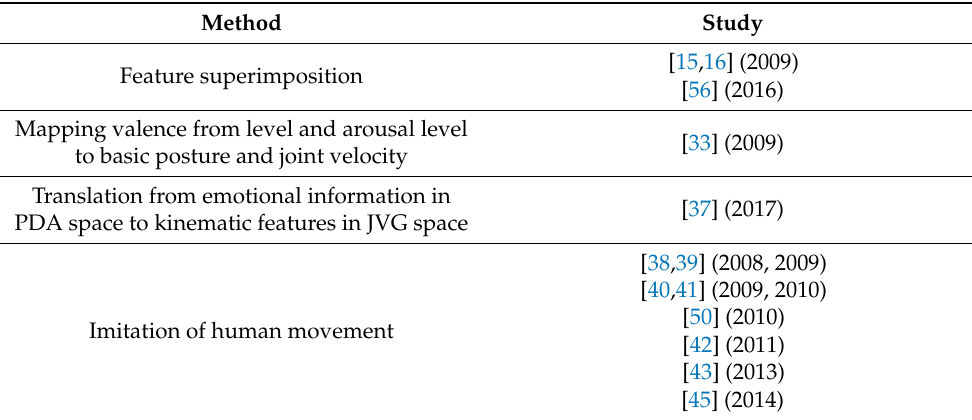
Table 4. Design methods for emotional